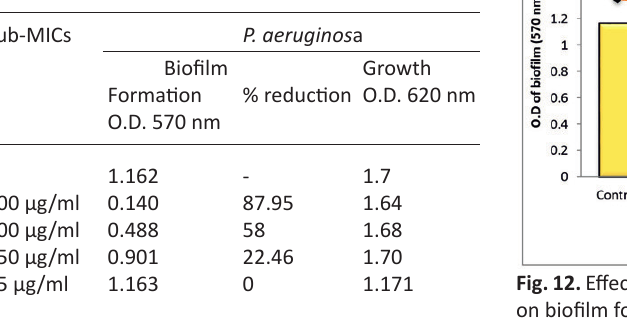
Table 8. Anti-biofilm effect of polyphenol fraction of Z. spina-christi on P. aeruginosa biofilm